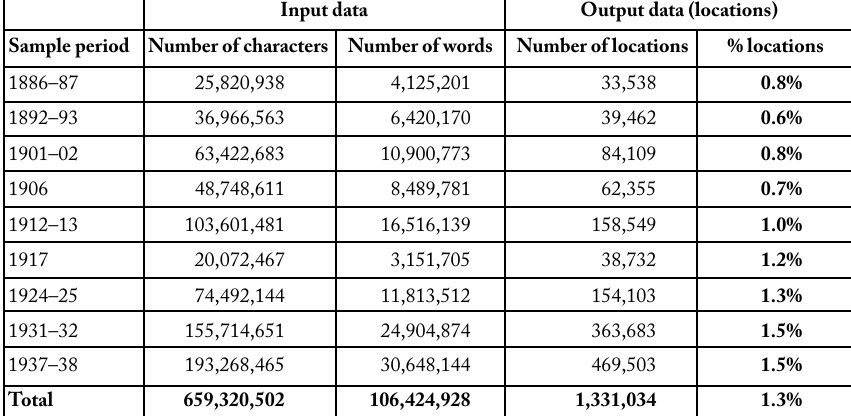
Table 2 Overview of number of words, characters, and locations in the dataset per sample period in Vooruit Input data